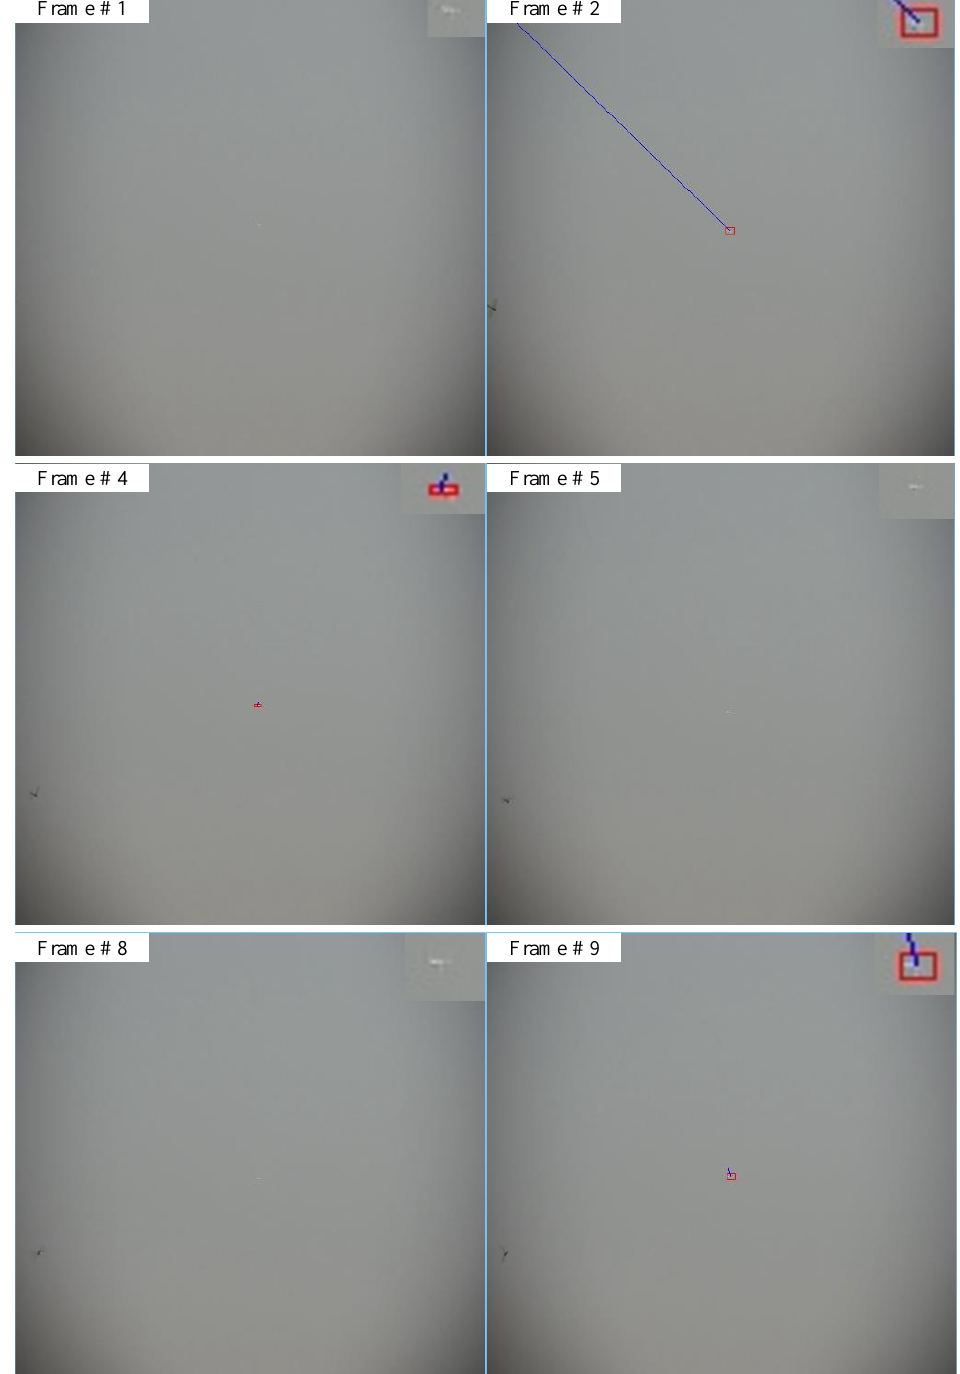
Figure 16. Detection and tracking result of the proposed method with a failure